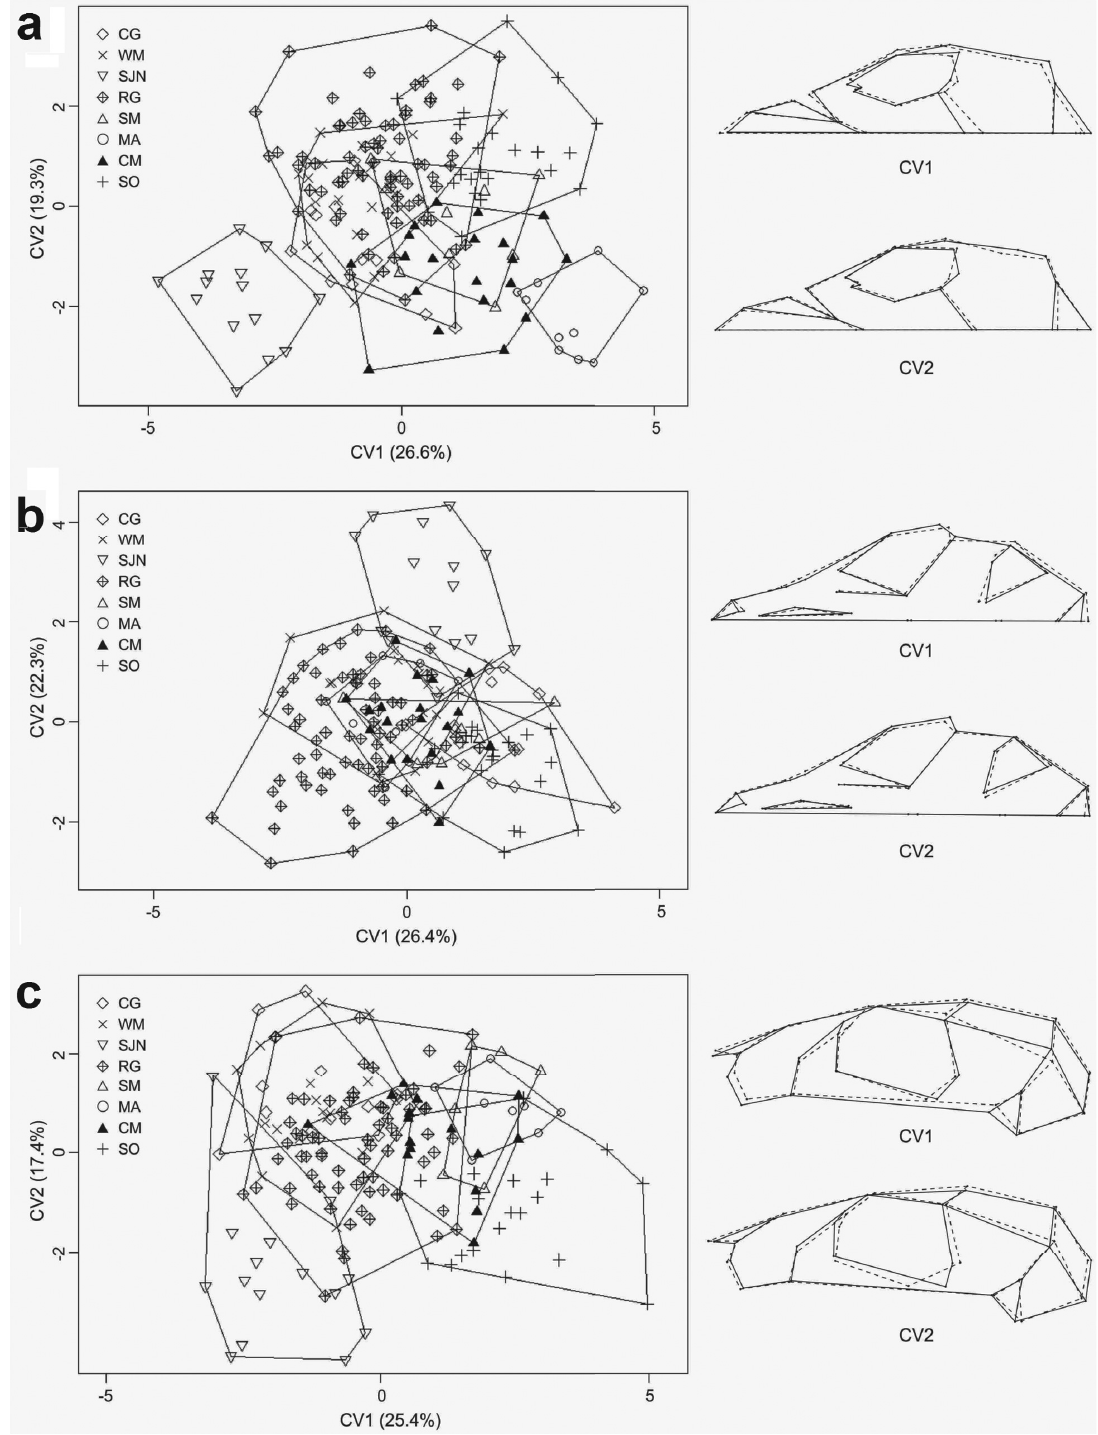
Figure 3 - Scatter plot of two fi rst axes of Canonical Variate Analysis (CVA) for Scapteromys tumidus skull shape con fi gurations of samples from eight geographic clusters in southern Brazil and Uruguay for dorsal (a) , ventral (b) and lateral (c) views. CV 1 represent skull shape variation in the fi rst axis and CV 2 represent skull shape variation in the second axis. Positive scores in solid lines and negative scores in dotted lines on the shape difference